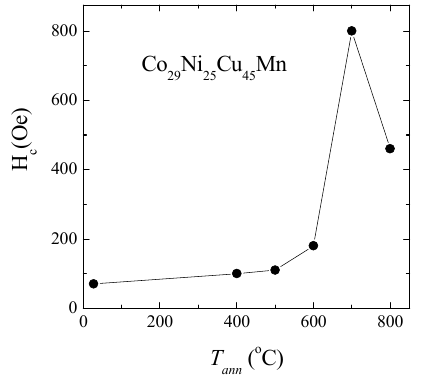
Figure 33. Effect of annealing temperature on the coercivity of the Co 29 Ni 25 Cu 45 Mn microwire. Reproduced from reference [98], Figure 3.